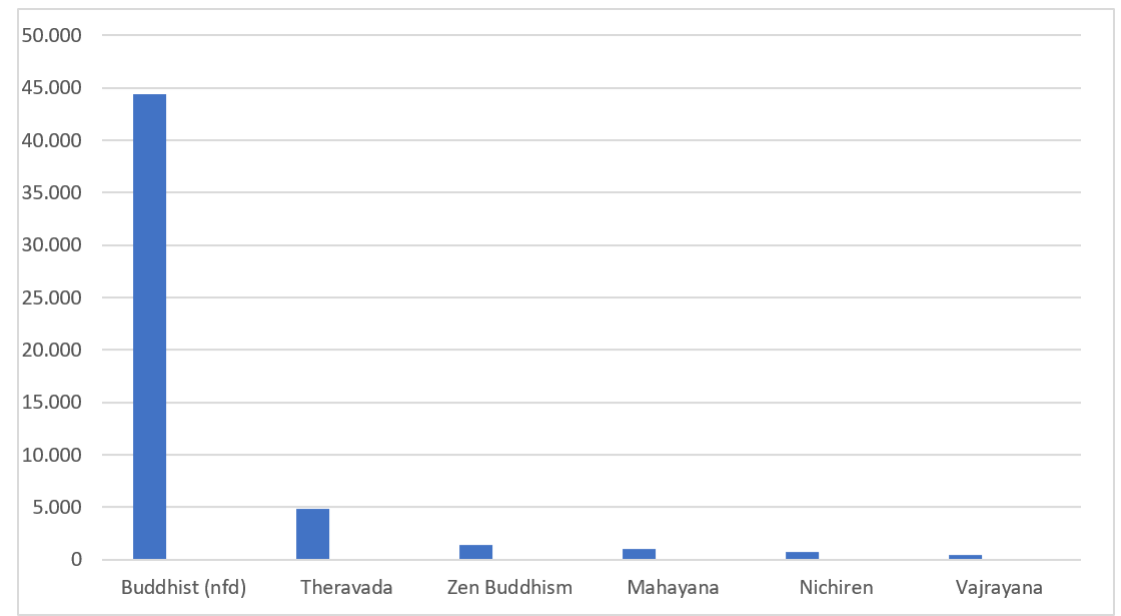
Figure 1: The Varieties of Buddhism in New Zealand (Statistics New Zealand 2018).